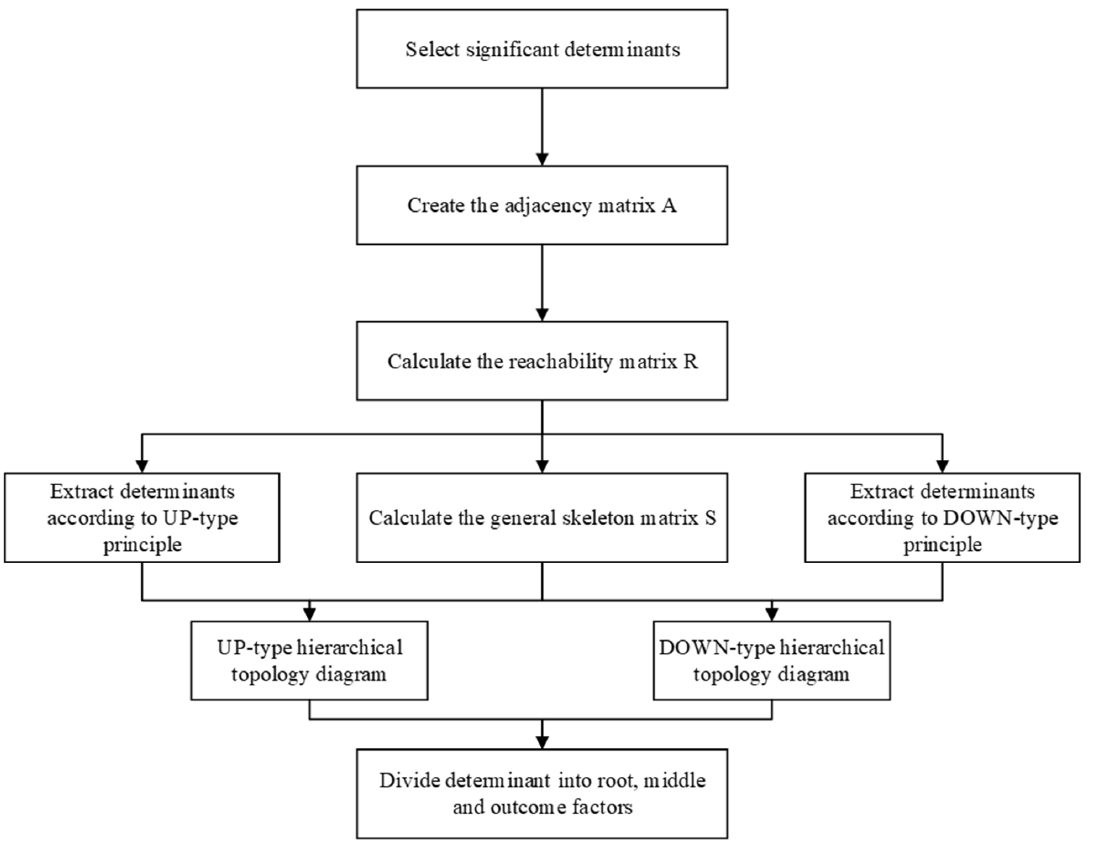
Figure 1. Flowchart of AISM model. The figure shows in detail the five steps of the AISM model.